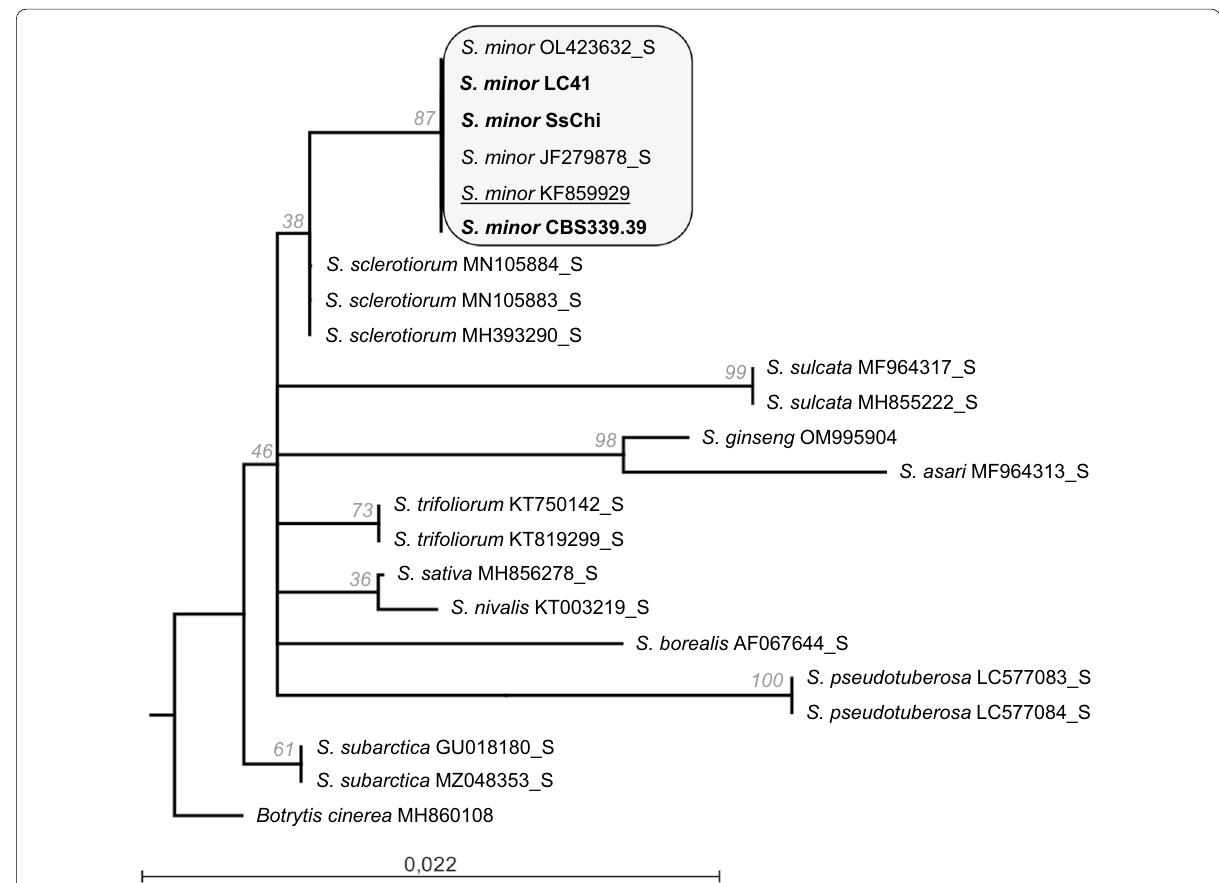
Fig. 7 Maximum likelihood phylogeny of Sclerotinia species. The isolates used in the study (indicated in bold) are grouped with known isolates of S. minor (grey box), including a reference sequence for S. minor isolate CBS 339.39